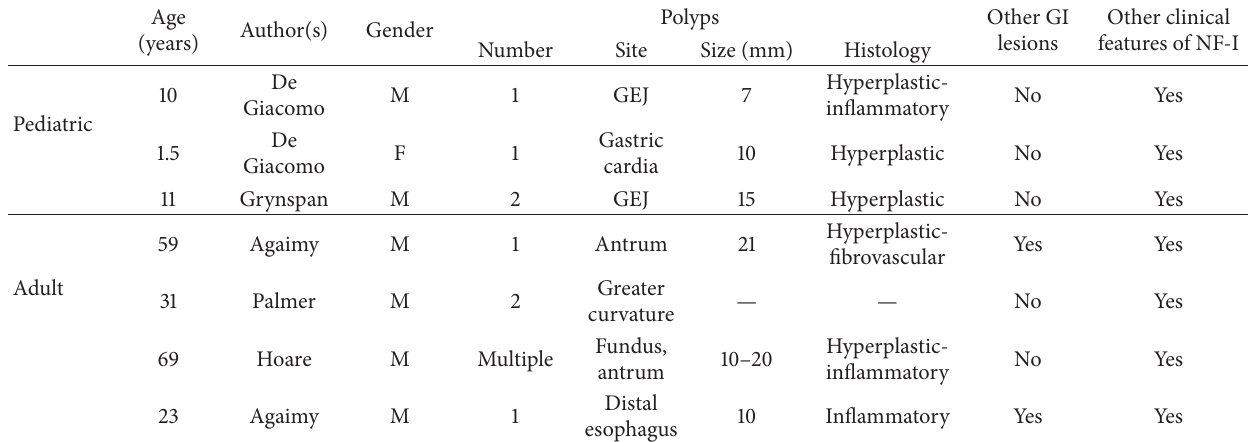
Table 1: Literature review of all hyperplastic/inflammatory (juvenile-like) gastric/GEJ polyps in patients with Neurofibromatosis Type 1 ( 𝑛 = 7